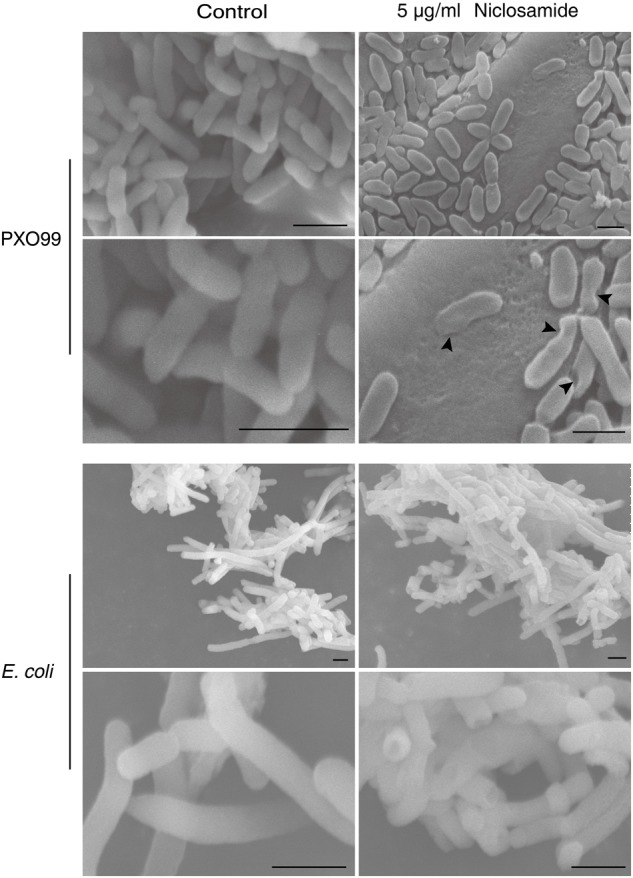
Niclosamide causes ultrastructural modifications in Xoo. Scanning electron microphotographs of Xoo treated with sterile distilled water (control) and with 5 µg/ml niclosamide. Black arrow indicates the damage caused by niclosamide drug. Bar = 1 µm.